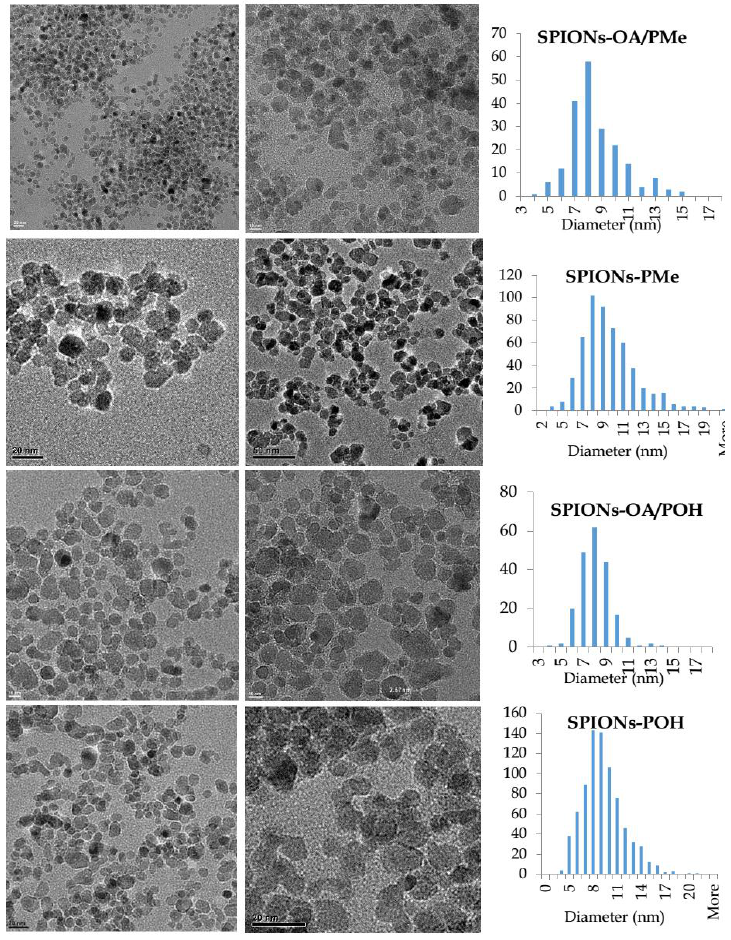
Figure 1. Transmission electron microscopy (TEM) images and histograms of size distribution for water-dispersible